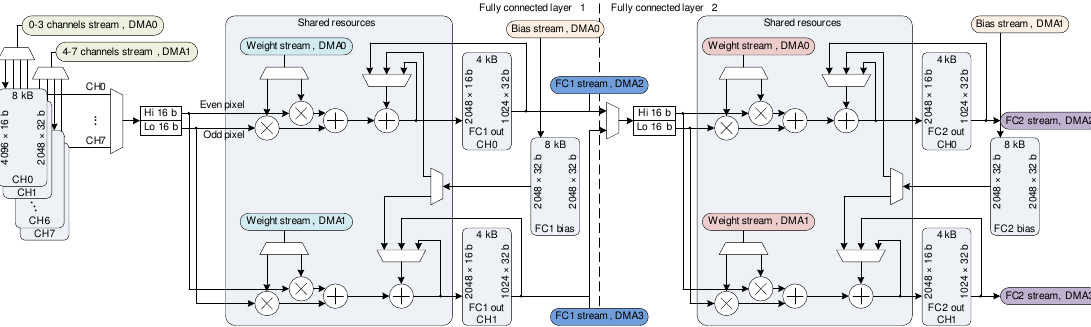
Figure 13. An example of the AXI stream-optimized architecture of two fully connected